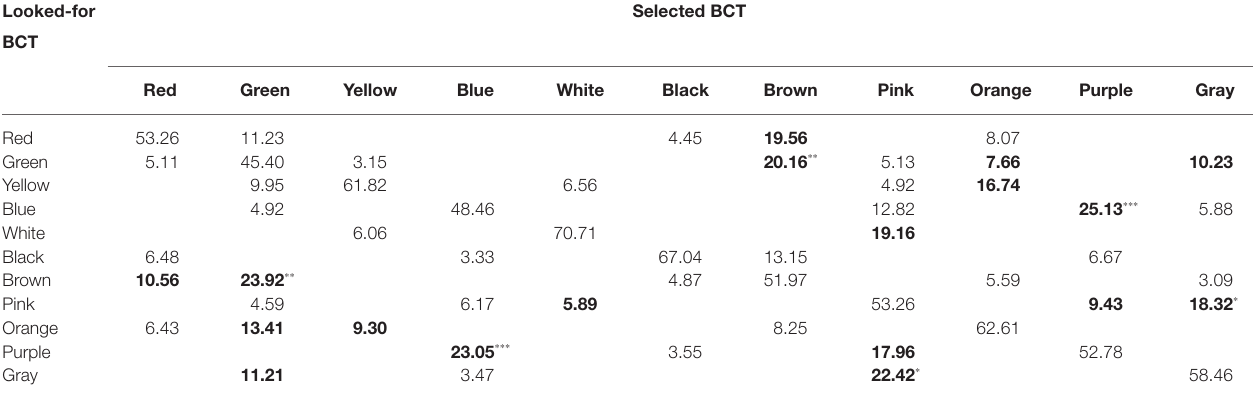
TABLE 1 | Protanope confusion matrix obtained in the pointing task.